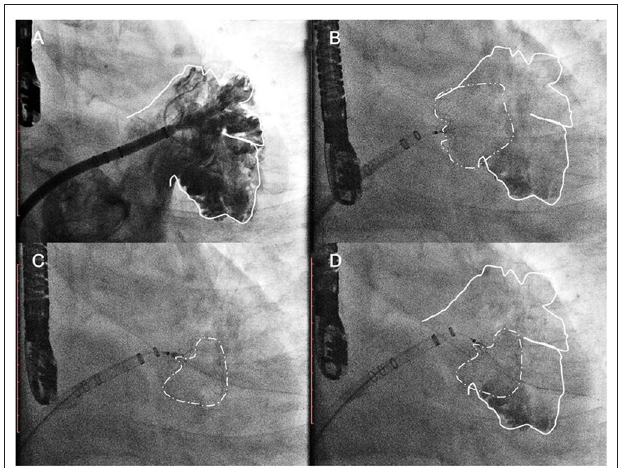
FIGURE 2 | The common implantation strategy sequence. Step 1 (A) initial angiographic injection at right anterior oblique (RAO) 30 ◦ Caudal 20; Step 2 (B) a 33-mm Watchman device was initially chosen as the first attempt. Acquiring detail of the LAA anatomy through the TEE/CTA images was necessary before the dual-device strategy was selected. Step 3 (C) In the first implantation step, we chose an appropriately sized device to close the more challenging lobe of the LAA. Step 3 (D) The tug test and TEE were used to evaluate the PASS criteria with the first